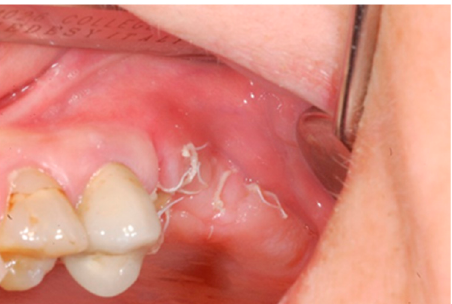
Figure 6. Vestibular intraoperative view of the oral mucosa 10 days after tooth extraction and socket preservation. Soft tissues appeared completely healed with no signs of bone exposition, considered as a clear sign of bisphosphonate-related osteonecrosis of the jaw (BRONJ).